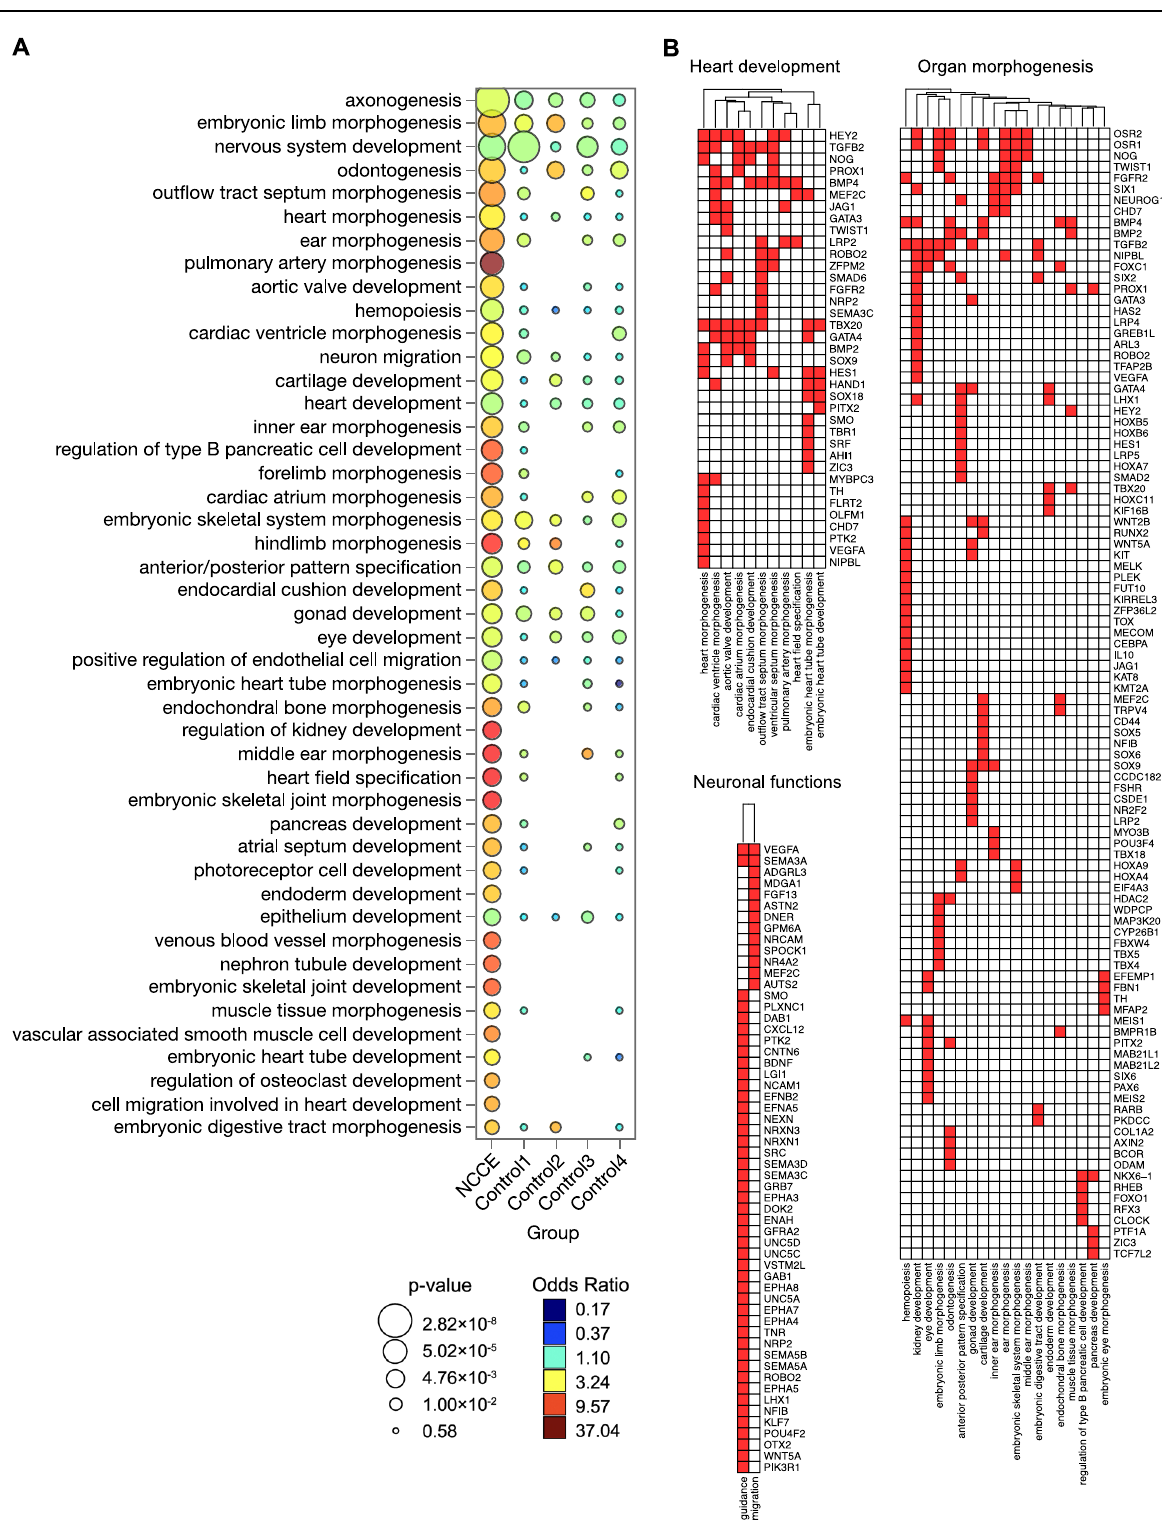
motifs separated by larger spacings (30 – 60bp). Controls 2 – 4: genes associated with conserved NKX motifs 6 – 16bp from conserved scrambled motifs GTAC(G/ C), AGTC(G/C), or TGGA(C/T), respectively. B NCCE+genes in select pathways associated with heart development, neuronal functions, and organ morphogenesis.